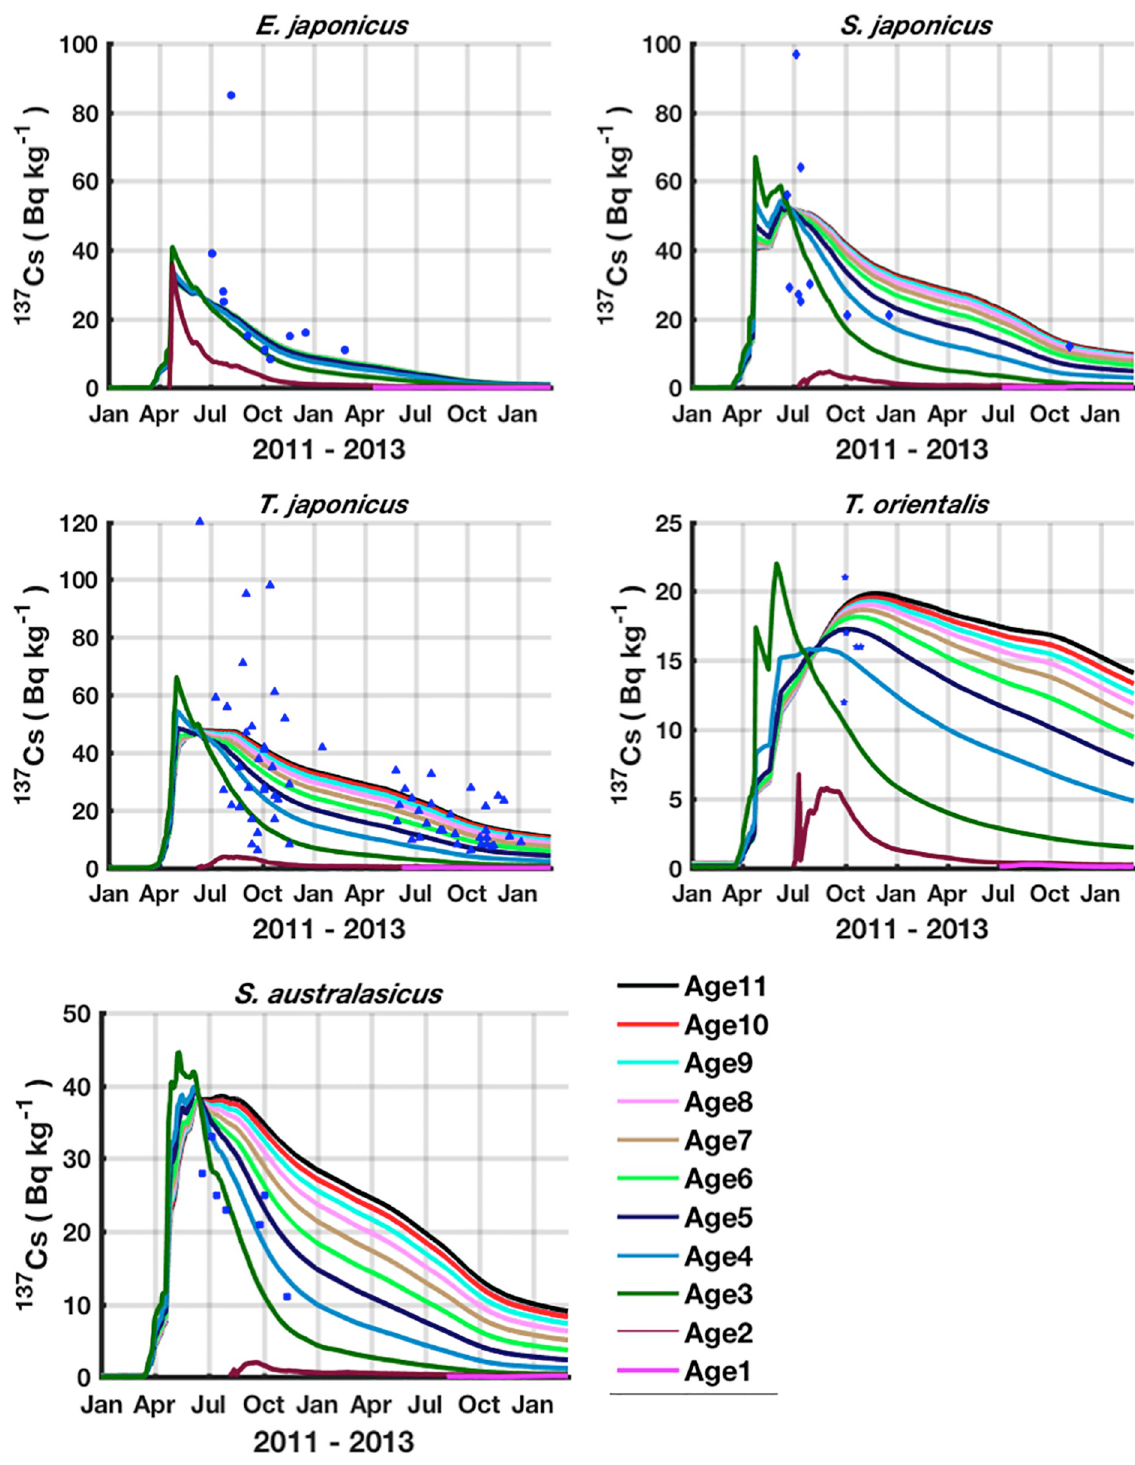
Fig 7. Time series of the predicted 137 Cs activity concentrations (Bq kg -1 wet weight) in the different cohorts (individuals born in the same year), confronted with the observed field data (coloured symbols) of 5 studied species (for which the data are available). For each species, 11 cohorts are represented (Age1 includes individuals aged from 0 to 1 years, Age2 includes individuals aged from 1 to 2 years, etc). Each curve represents the dynamics of 137 Cs activity concentration in only one cohort. For each cohort, the shown 137 Cs activity concentration corresponds to the median of the 35 sites of the high spatial resolution area (see Fig